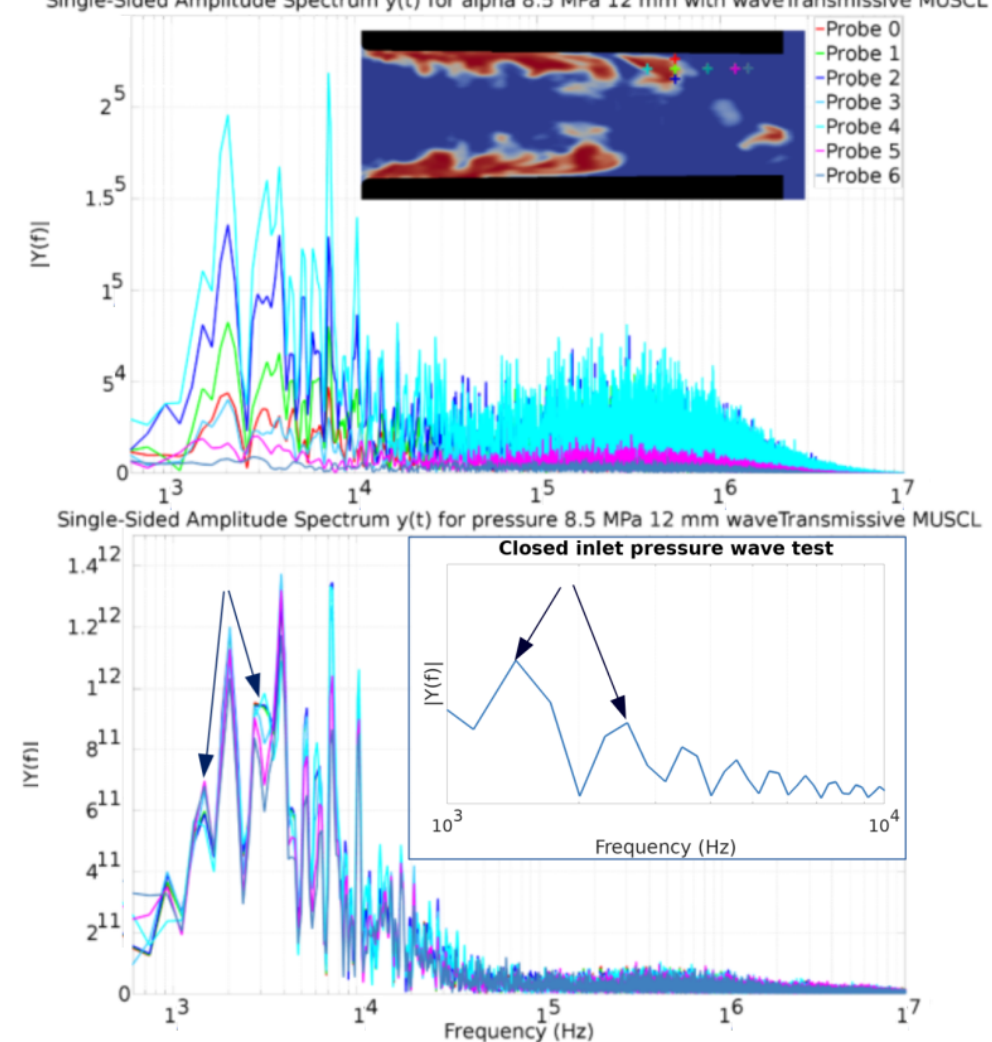
Figure 17. Frequency response for p dif f = 8.5 MPa with 12 mm chamber geometry with the wave transmissive boundary condition which corresponds to a flow time of 3.25 ms, superimposed is the frequency response for pressure from the 2D wave propagation test. The arrows indicate the resonant frequencies obtained from the